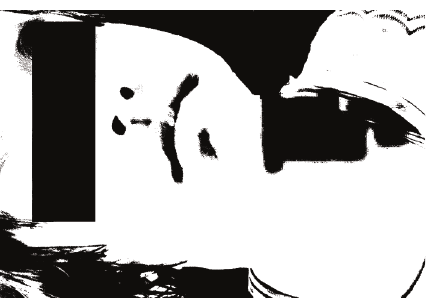
Figure 1: A 4 × 4 cm mass appeared on her right side of the neck on straining (Valsalva maneuver).